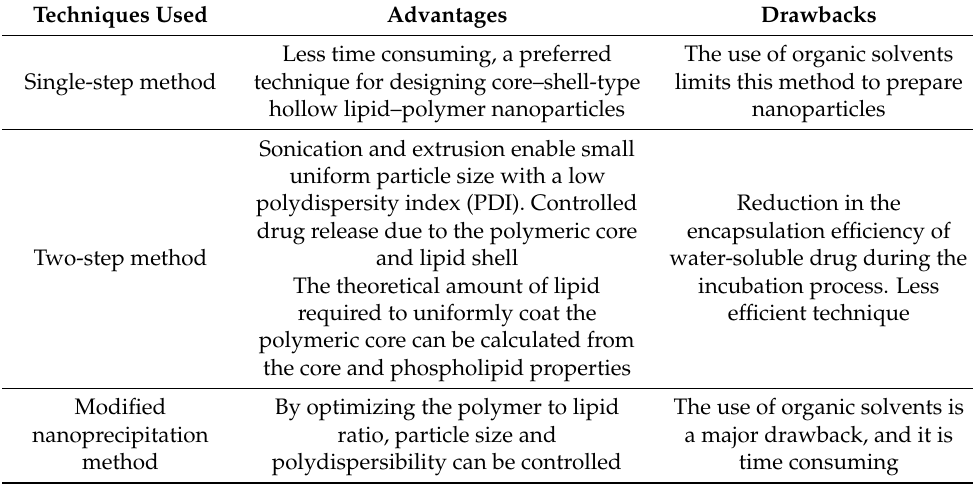
Table 2. Comparison of formulation techniques used to prepare the polymeric lipid hybrid nanopar- ticles